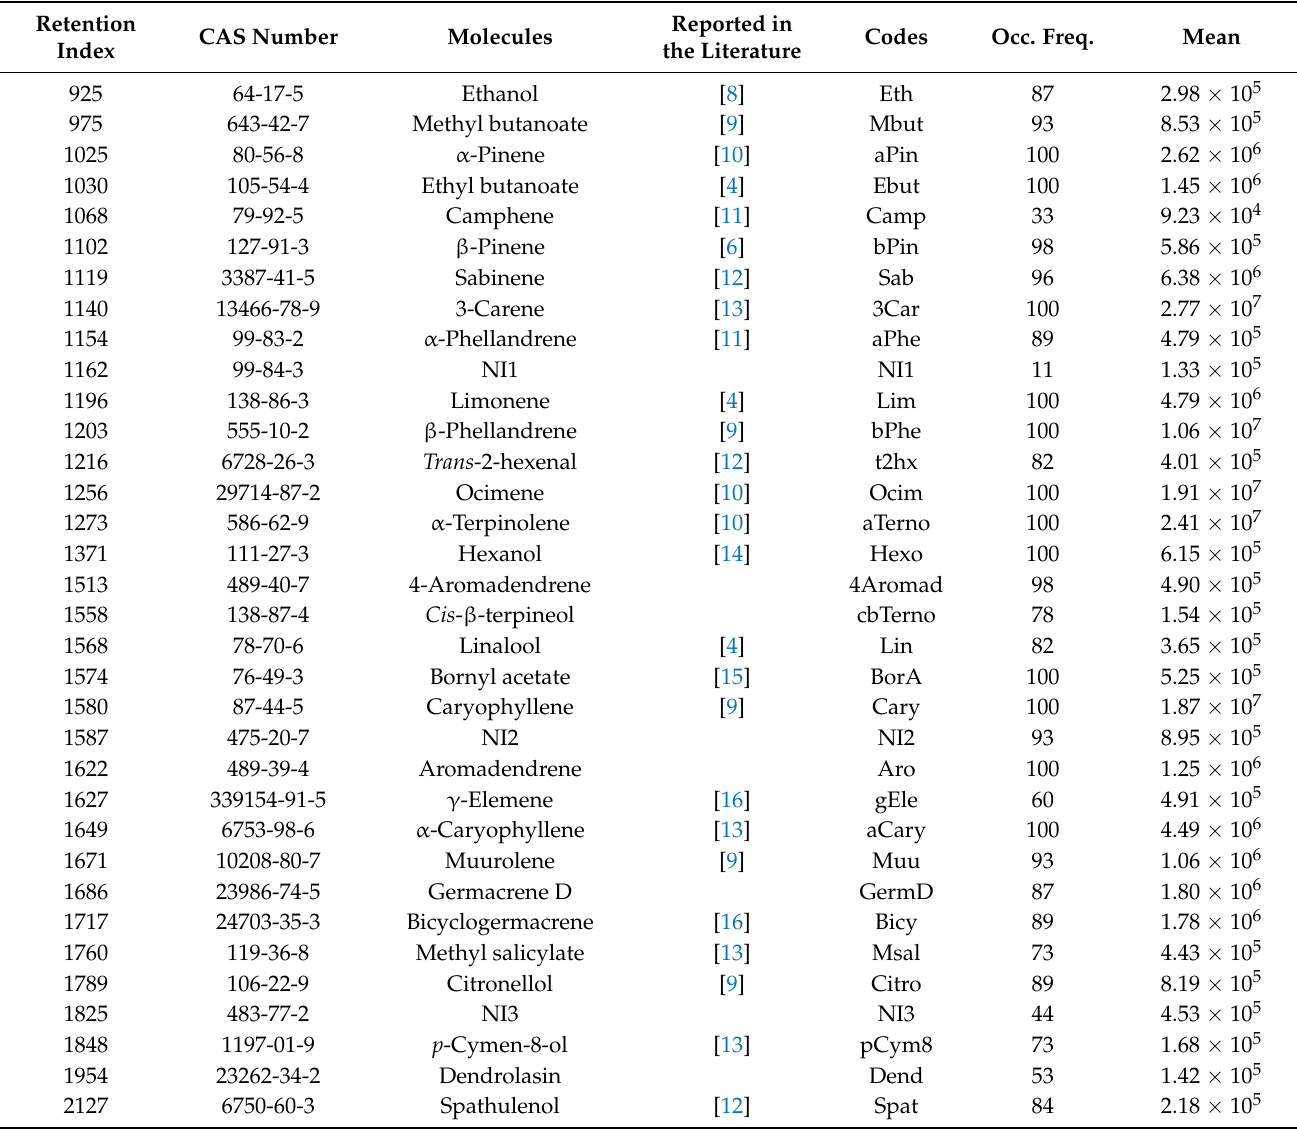
Table 1. List of volatile compounds detected and identified in the headspace of berries for the 15 different cultivars.